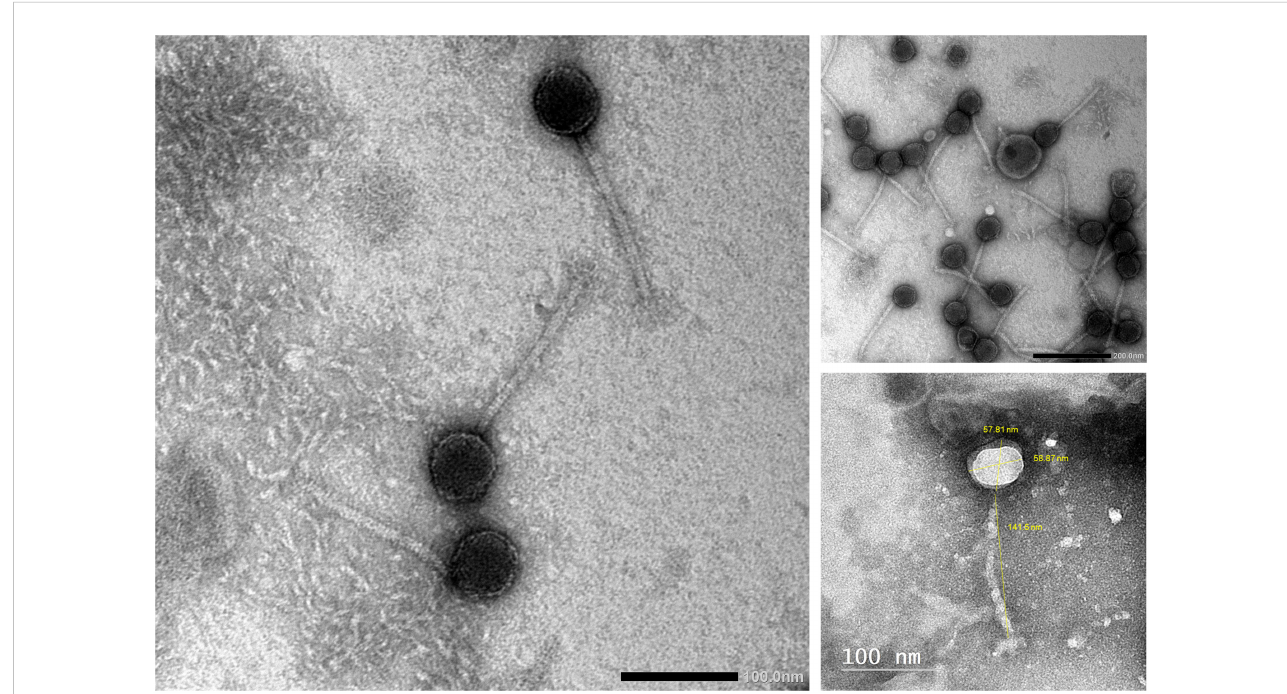
FIGURE 3 Transmission electron micrograph of phage vB_Kpn_ZCKp20p. Phage particles were negatively stained with 2% (w/v) phosphotungstic acid and obtained by JEOL 1230 at a scale bar of 100 nm. The virion dimensions were measured by ImageJ version